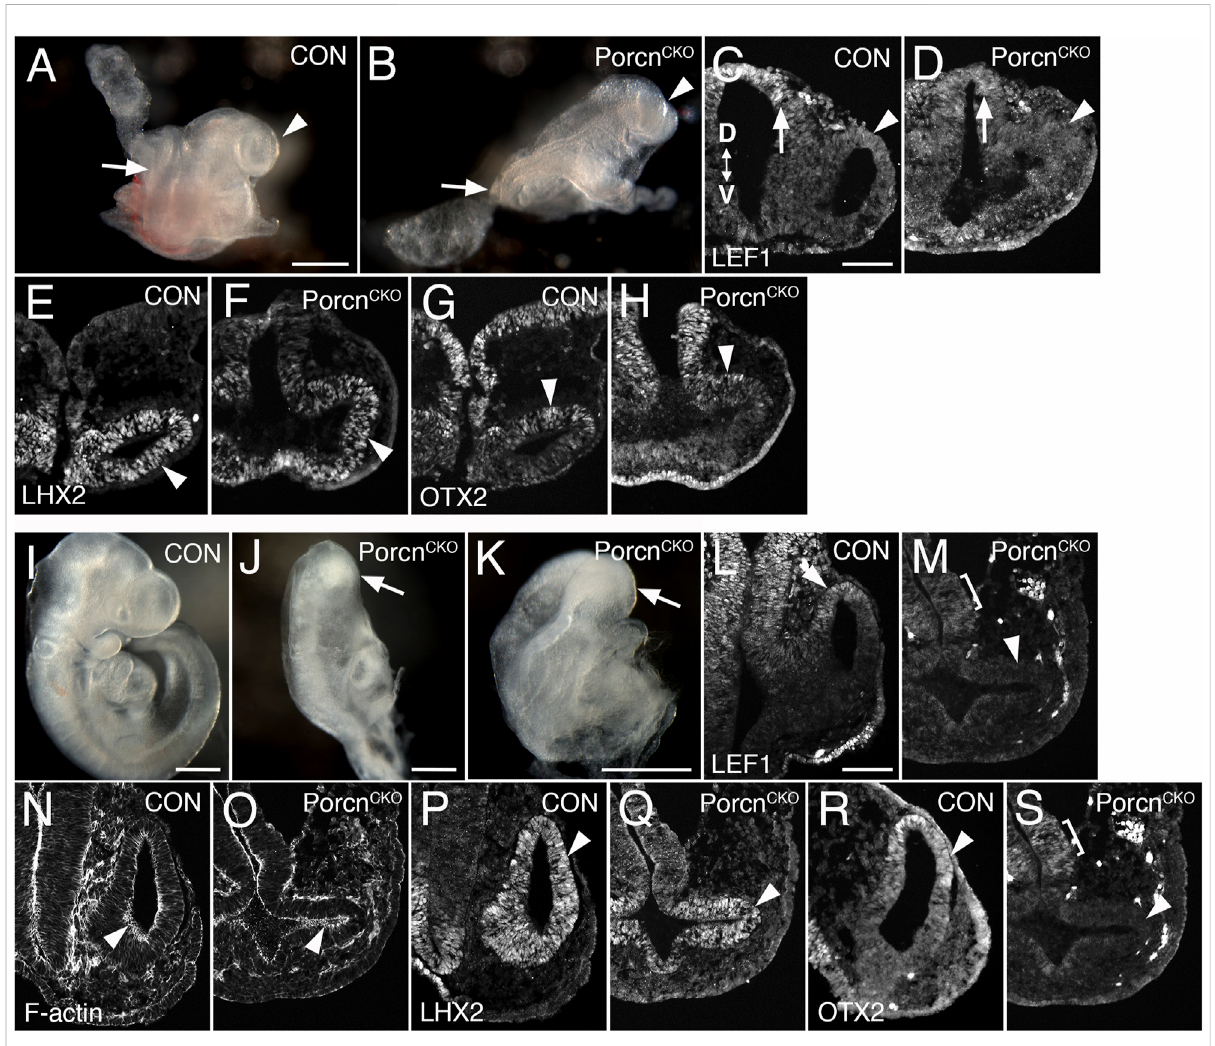
FIGURE 1 Conditional Porcn inactivation before eye fi eld formation (E6.5) interferes with early OV morphogenesis. (A – H) Embryos at E8.75-E9.0. (A) Controlembryo(8somites)withOVs(arrowhead). (B) Porcn CKO withcaudaltruncation(arrow;somitesnotdetectable).Headdevelopmentproceeds atthisstageandOV-likestructuresarepresent(arrowhead). (CandD) LEF1expressionin13somiteembryos.Coronalcryostatsectionsshowslightly decreased LEF1 expression in the dorsal OV of Porcn CKO (D; arrowhead), expression in the dorsal and ventral forebrain is largely maintained (D; arrow). (E – H) : 7-8 somite embryos. (F) LHX2 is robustly expressed in the mutant OV (arrowhead). (H) In Porcn CKO , OTX2 expression is present in the dorsalOV(arrowhead). (I – S) EmbryosatE9.5(20 – 23somites);2of3embryosshoweddistinctOVs,shownherein (J – S) . (J – K) Examplesof Porcn CKO showing severe abnormalities throughout the body, including the heads (arrows). (M) LEF1 expression is absent in Porcn CKO OV (arrowhead), low expression is detectable in the adjacent diencephalon (bracket). (O) Phalloidin labeling shows that apicobasal polarity is largely maintained in Porcn CKO (arrowhead). (Q) In the mutant OV, LHX2 is robustly expressed, similar to controls (arrowhead). (S) OTX2 is absent in the OV of Porcn CKO (arrowhead).Weakexpressionisdetectableintheforebrainneuroepithelium(bracket).Controls: Porcn CHET .OV:opticvesicle.D < - > V:Dorsoventral orientation. Scale bars A, B, I – K: 0.5 mm; C, L: 0.1